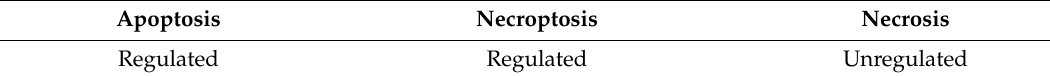
Table 1. Comparison between cellular characteristics in apoptosis, necroptosis and